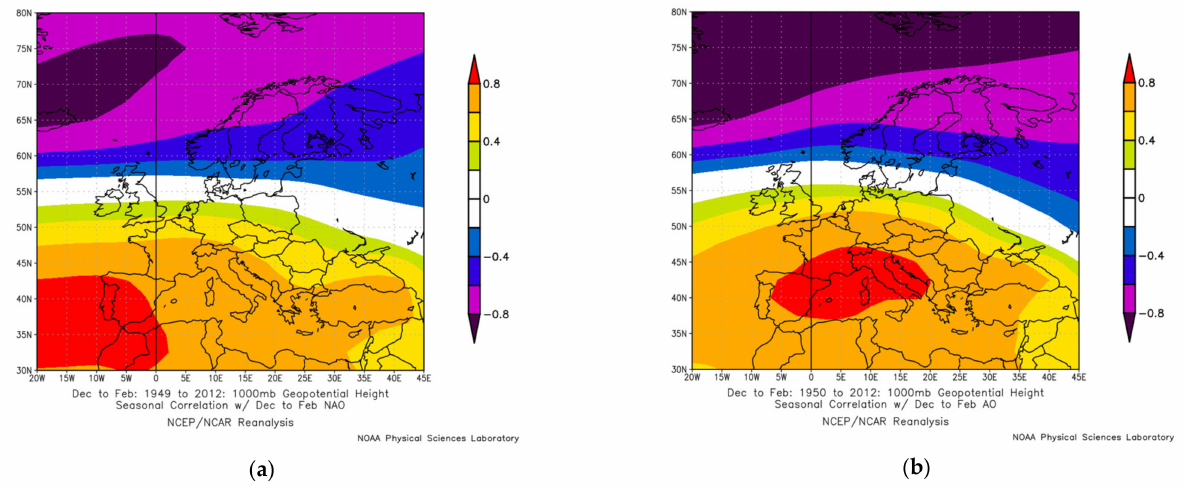
Figure 9. Winter correlations of the 1000 hPa geopotential height with the ( a ) NAO and ( b ) AO indices. Correlation coefficients r < − 0.2 and r > +0.2 are significant at the 90% confidence